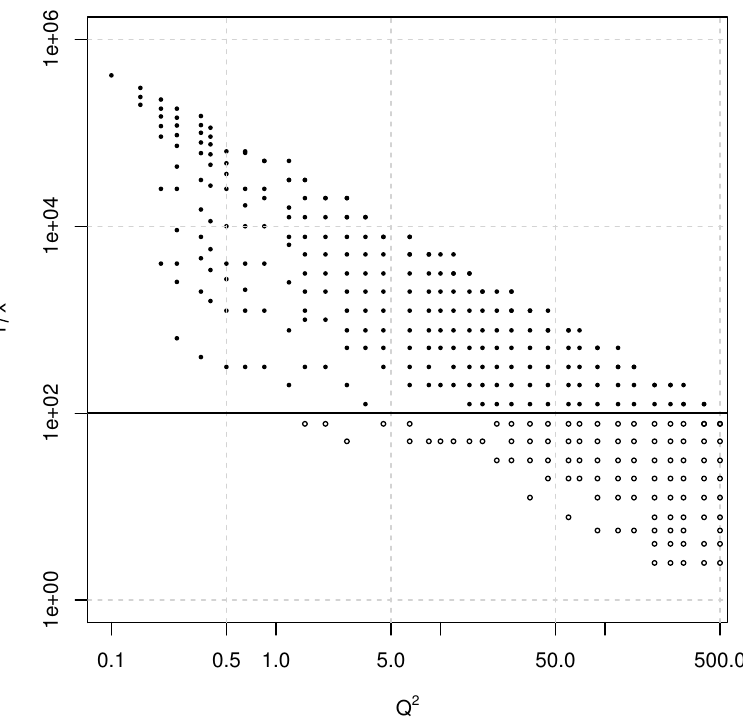
Figure 1 . Values of x and Q 2 for the data points analysed in this paper [3]. Regge kinematics restricts this domain to x < 0 :